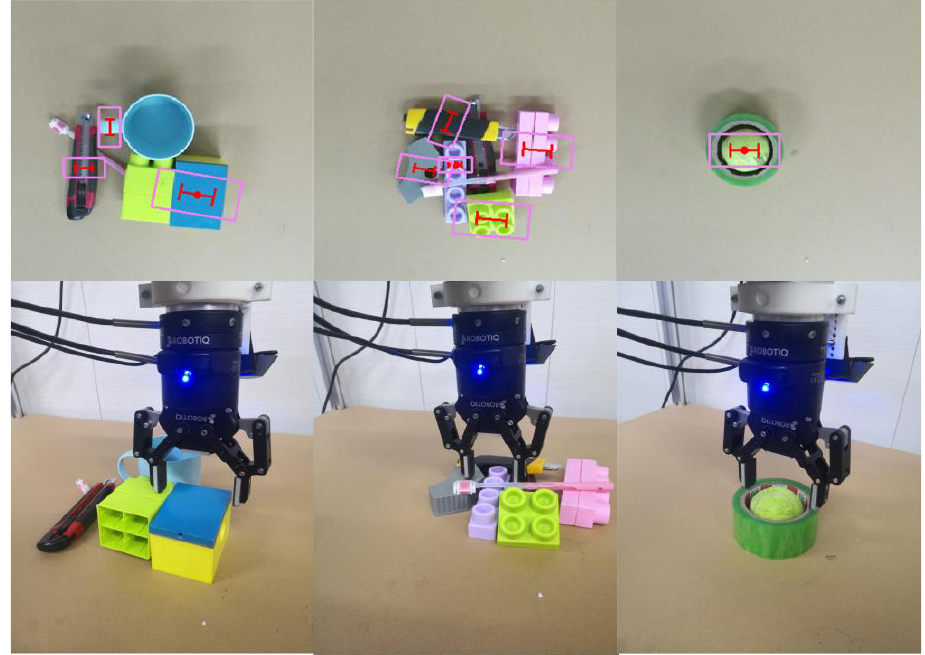
Figure 11. Examples of failed grasping; the most common failed grasping is that the gripper is blocked by other